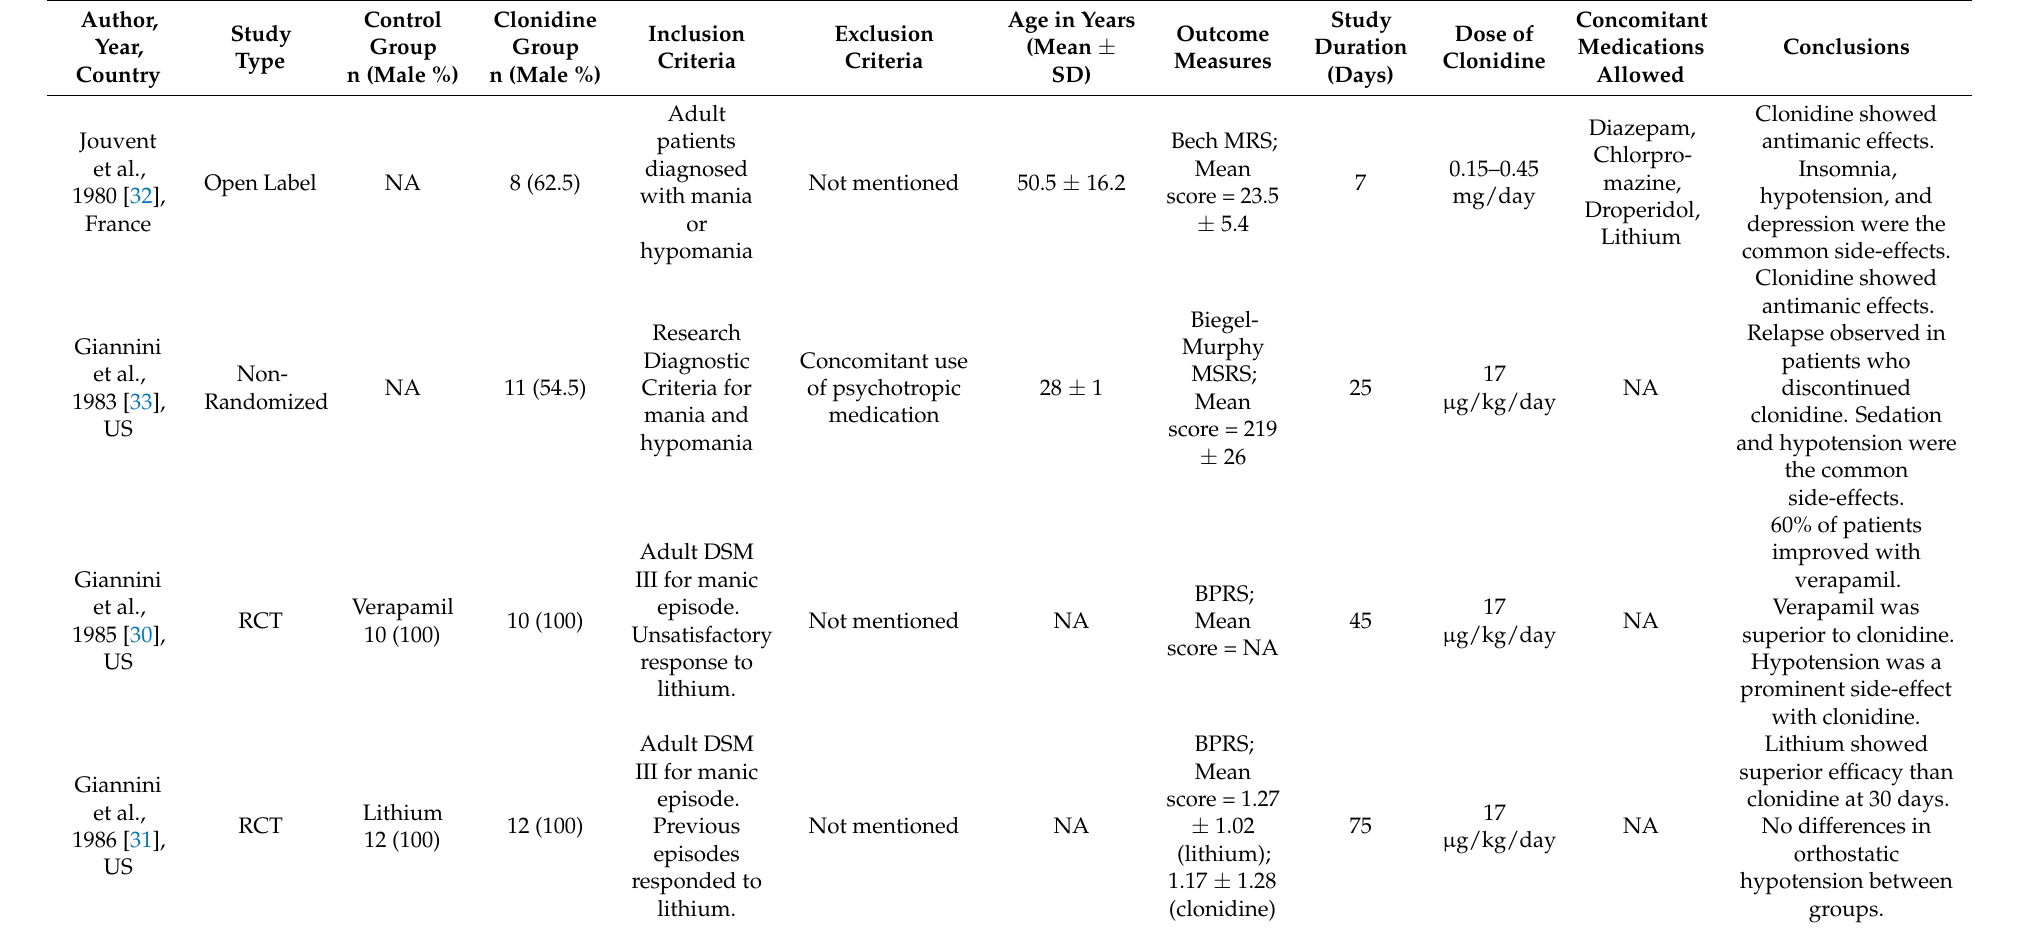
Table 1. Characteristics of the included